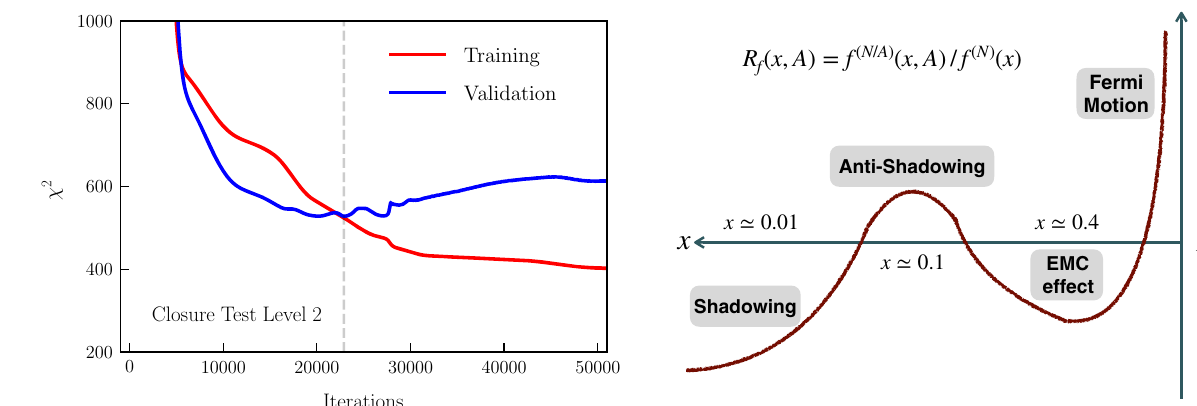
Fig. 10 Same as Fig. 7, but now for the Level 2 closure test. We show the separate χ 2 values of the training (solid red line) and the valida- tion (solid blue line) samples, and indicate with a vertical dashed line the stopping point for this specific replica, determined as the absolute minimum of χ 2 val